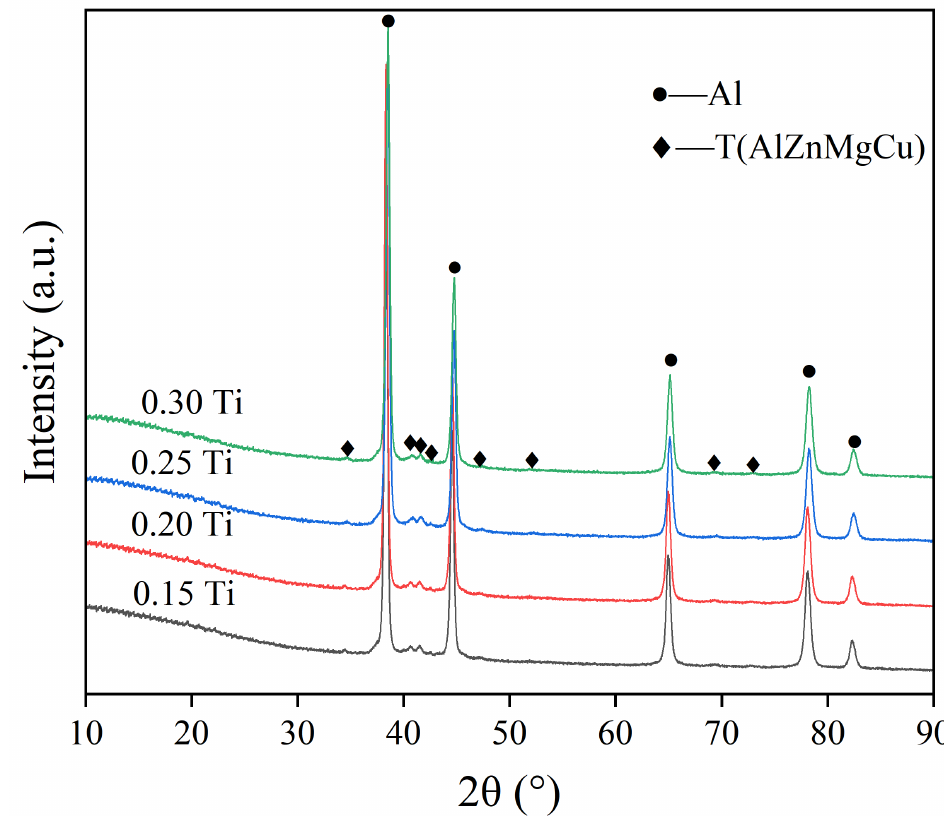
Figure 5. XRD patterns of alloys with different Ti contents. Statistical analysis was conducted on the mechanical properties of Al-Zn-Mg-Cu alloys with different degrees of refinement (Figure 6). With the increase in Ti content, the tensile strength of the samples increased at first and then decreased. Among the four additions, the alloy with 0.2 wt.% Ti content had the highest ultimate tensile strength of 270 MPa in the as-cast state, 32% higher than that of alloys with 0.15 wt.% Ti content. When the Ti content is higher than 0.2 wt.%, the tensile strength of the samples started to decrease. Moreover, with the increase in Ti content, the elongation of the samples increased at first and then decreased, and remained stable afterwards, the values of which were 0.31%, 1.00%, 0.52%, and 0.60%, respectively. It showed that the plasticity of Al-Zn- Mg-Cu alloys with Al-Ti-C refiner was related to the Ti concentration.